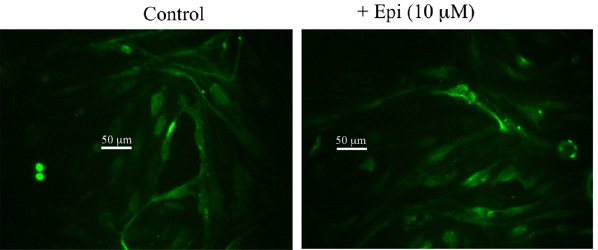
Fig 7. Expression of M6P receptor on nonpermeablized primary monolayer cultures of mouse brain endothelial cells. Receptor was detected on cells not treated with epinephrine and treatment did not enhance intensity of